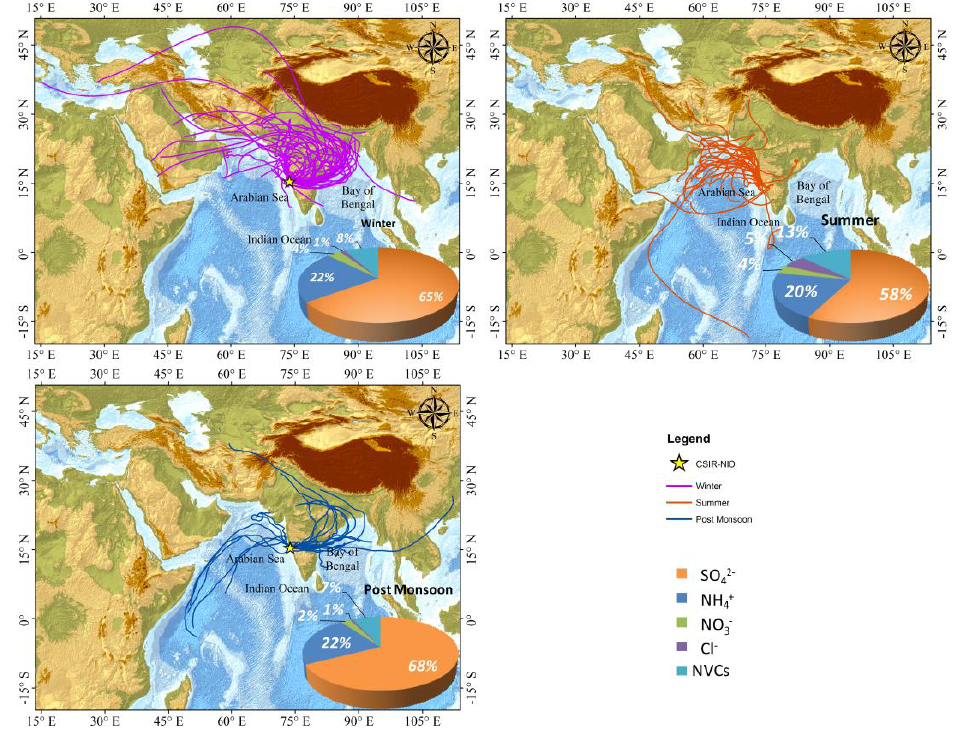
Figure 10. Seven-day Air Mass Back Trajectories ending at the sampling site at an altitude of 500 m.